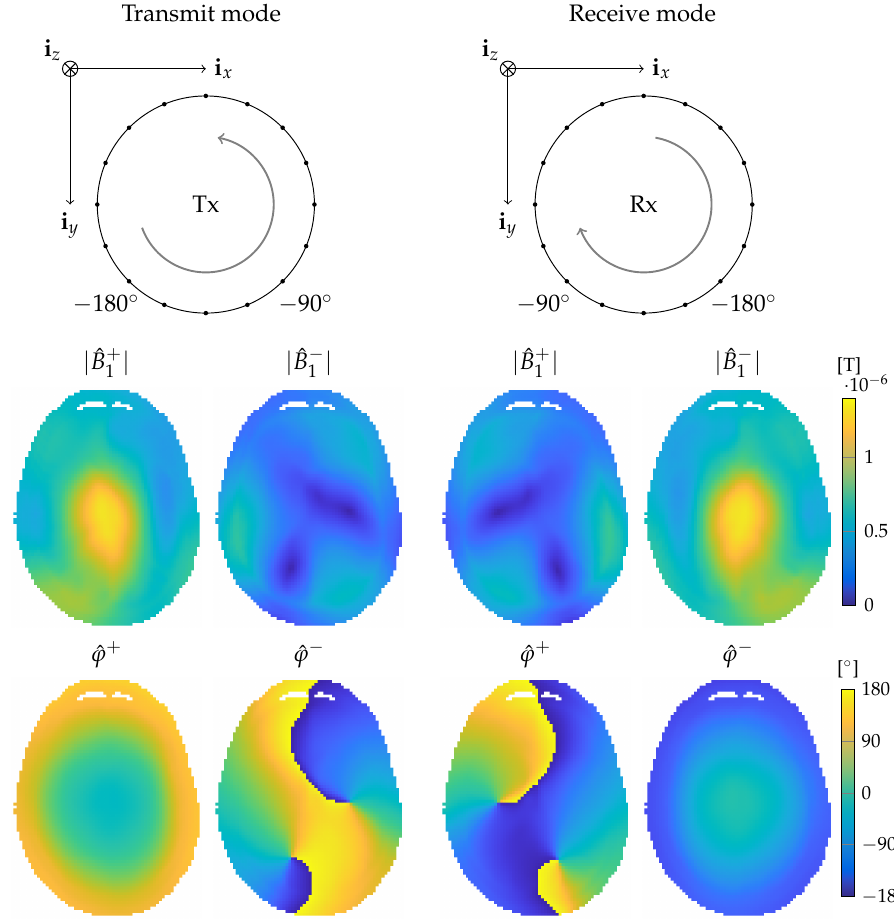
Figure 1. The transmit and receive mode of a tuned 16 rung 7 T MR head coil loaded with the Duke body model [29] and their corresponding transmit and receive fields (magnitude and